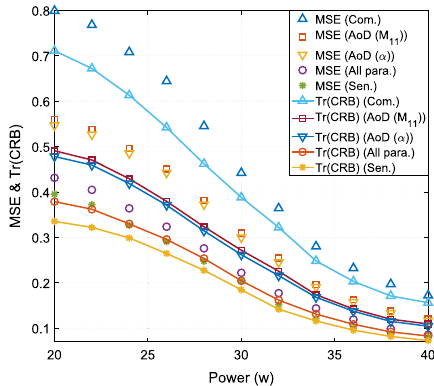
Fig. 5 Comparison of MSE and Tr(CRB) for parameter